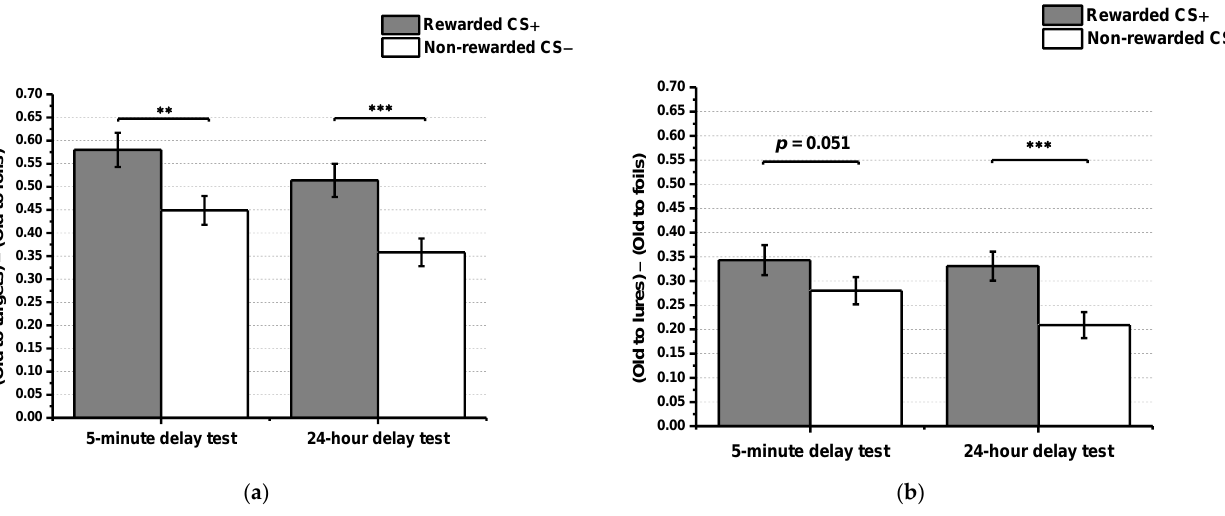
Figure 2. ( a ) Recognition memory performance. The corrected memory score was greater for items in the CS+ compared to the CS − category in the 5 min delay test condition and the 24 h delay test condition. For example, the mean corrected memory score of the CS+ category in the immediate test condition was 0.59, obtained by 0.66 (the mean of responding old to targets) minus 0.07 (the mean of responding old to foils) in the first row of Table 2. ( b ) Episodic memory generalization. The episodic generalization score was greater for items in the CS+ compared to the CS − category in the 5 min delay test condition and the 24 h delay test condition. For example, the mean generalization score of the CS+ category in the 5 min delay test condition was 0.34, obtained by 0.41 (the mean of responding old to lures) minus 0.07 (the mean of responding old to foils) in the first row of Table 2. Error bars represent ± SEM. *** p < 0.001, ** p < 0.01.